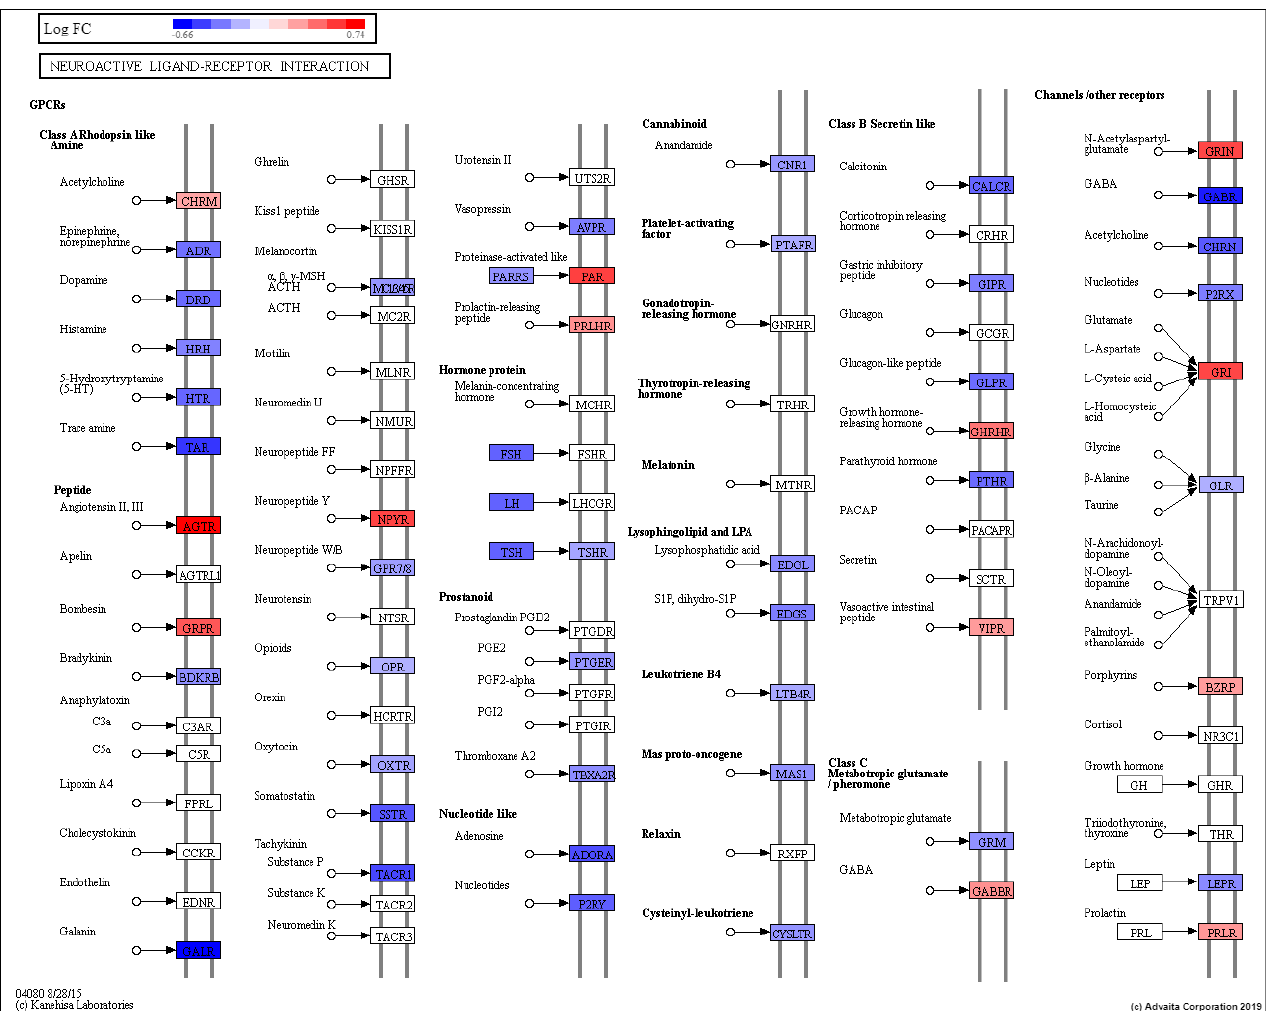
Figure 4. Neuroactive ligand-receptor interaction pathway (KEGG: 04080) showing gene regulation based on EA vs. AA prostate DE analysis (EA is control, AA is test). RED: upregulated, BLUE: downregulated.